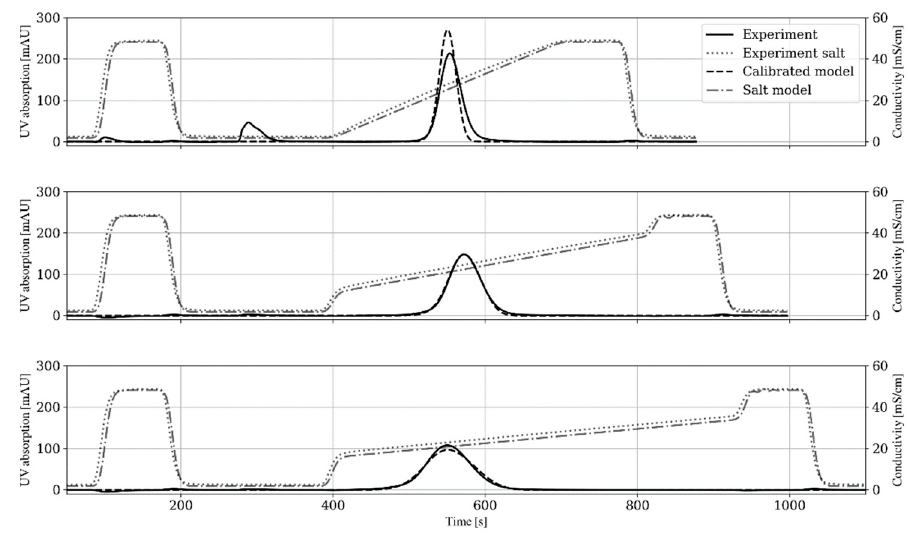
Figure 3. Three gradient experiment results with calibrated simulation. The gradient was successively made flatter and longer for each experiment, making the sample protein elute at slightly different times.